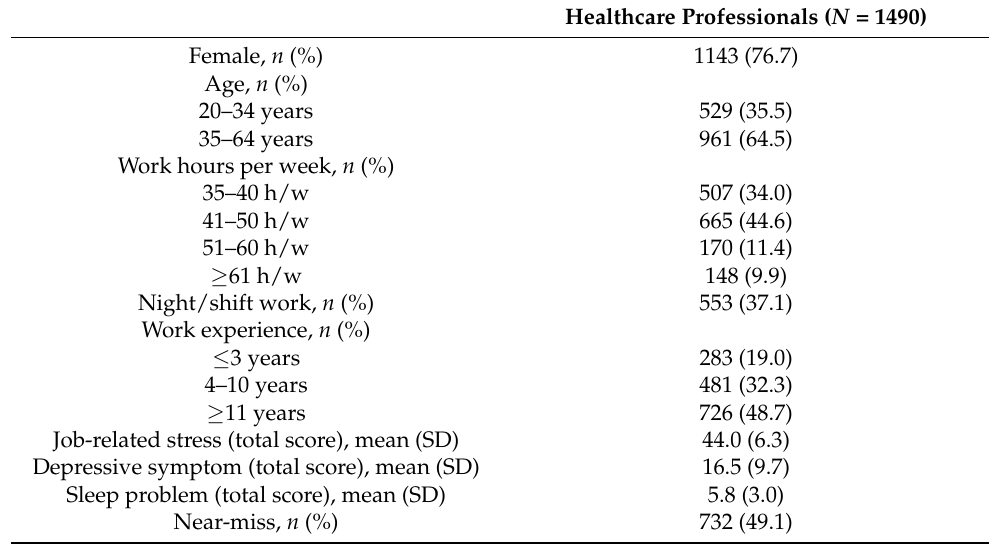
Table 1. Demographics and characteristics of healthcare professionals at the time of the